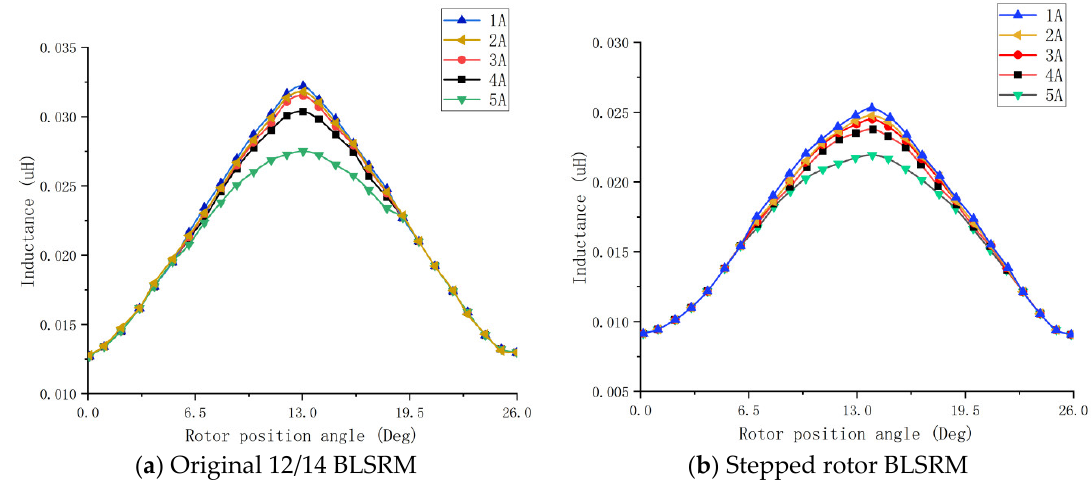
Figure 16. Inductance characteristic curve of torque windings.